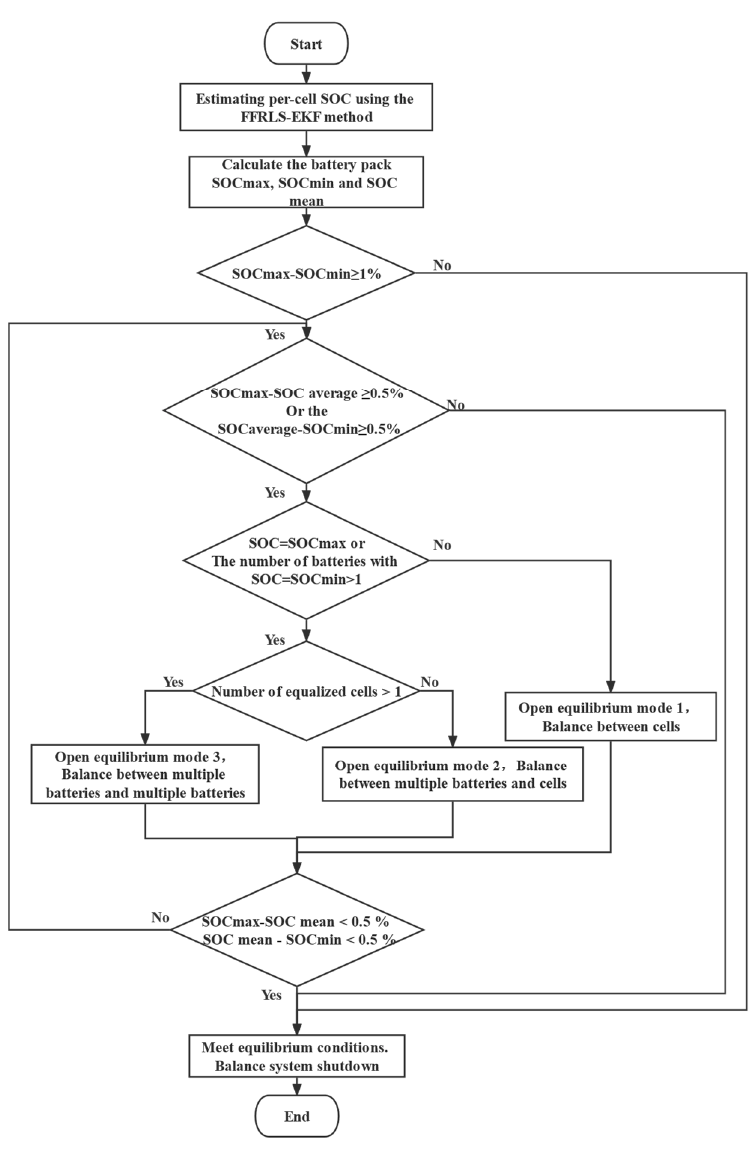
Figure 11. Balancing strategy flow